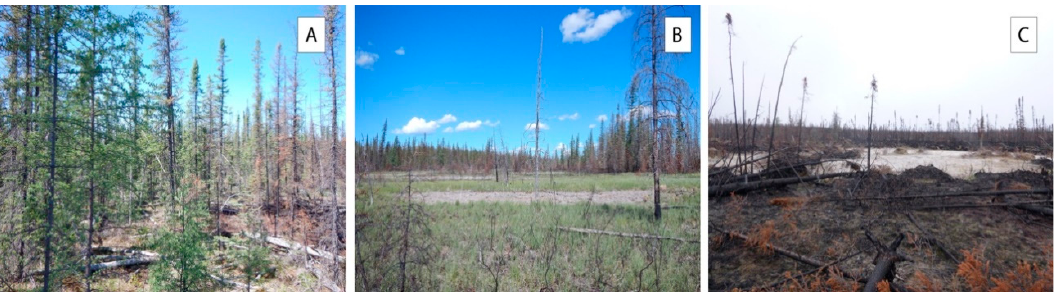
Figure 2. Examples of low ( A ), moderate ( B ) and high ( C ) burn severity one year post-fire in the Northwest Territories, Canada.